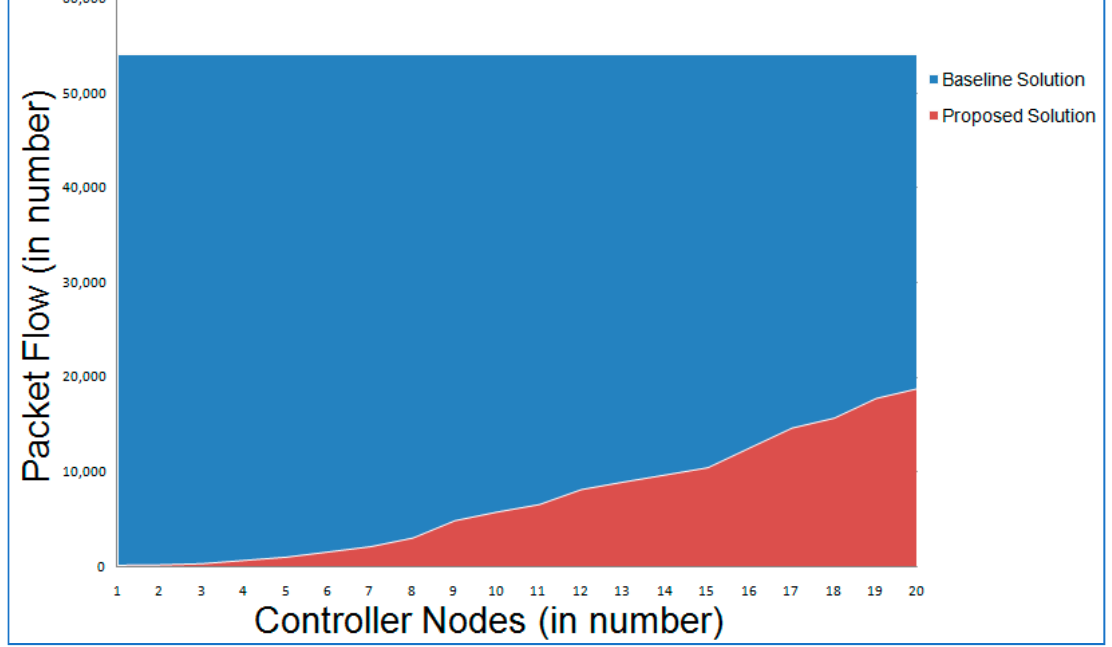
Figure 7. Packet flow comparison with baseline based on number of controller nodes.